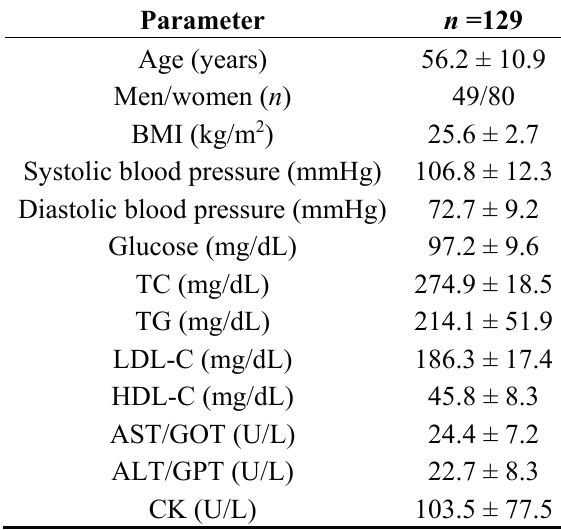
Table 1. Clinical and demographic characteristics of the study group.